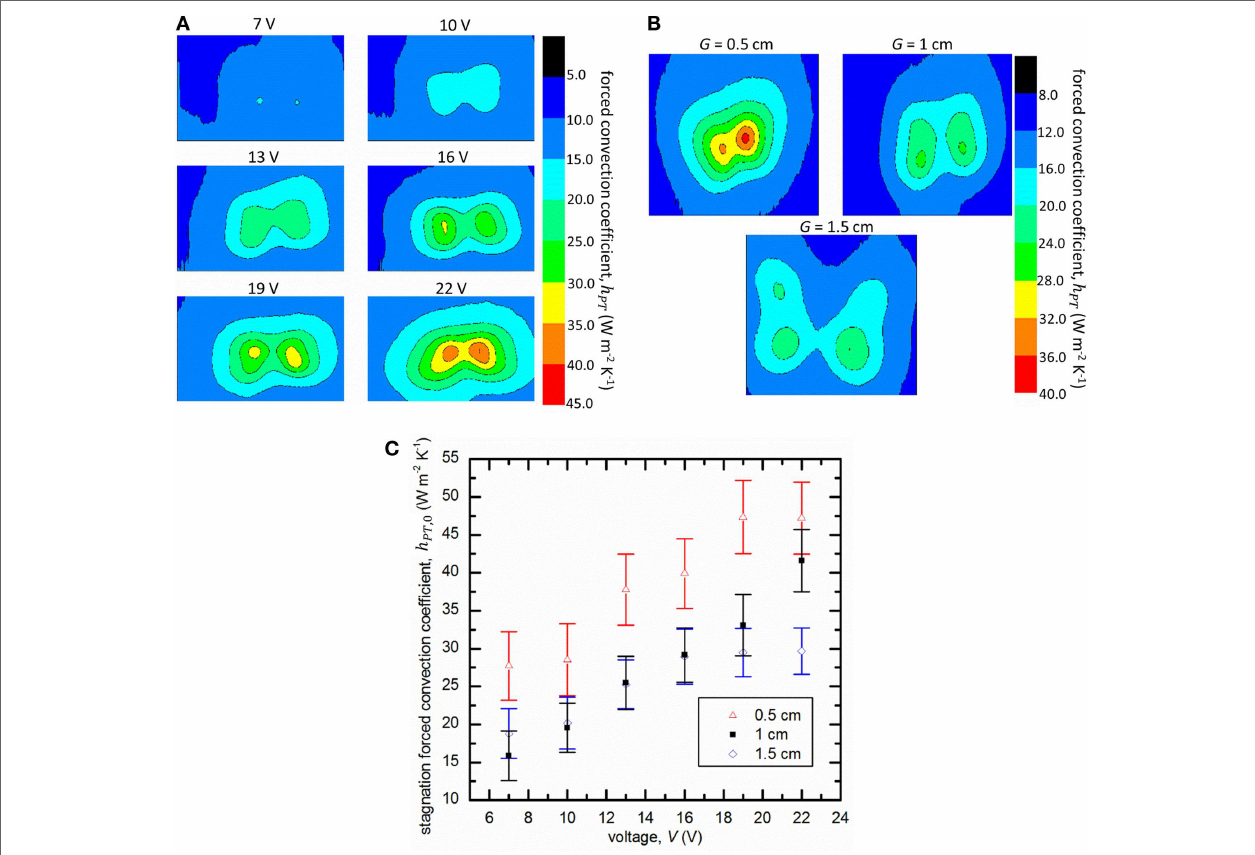
FIGURE 8 | (A) The local forced convection coefficient h PT as a function of input voltage for the rectangular piezoelectric when the PT was placed G = 1cm from the plate. (B) The local forced convection coefficient h PT as a function of gap distance from the plate, G , where the input voltage was 13V. (C) The stagnation coefficient h PT,0 for different gap distances as a function of the input